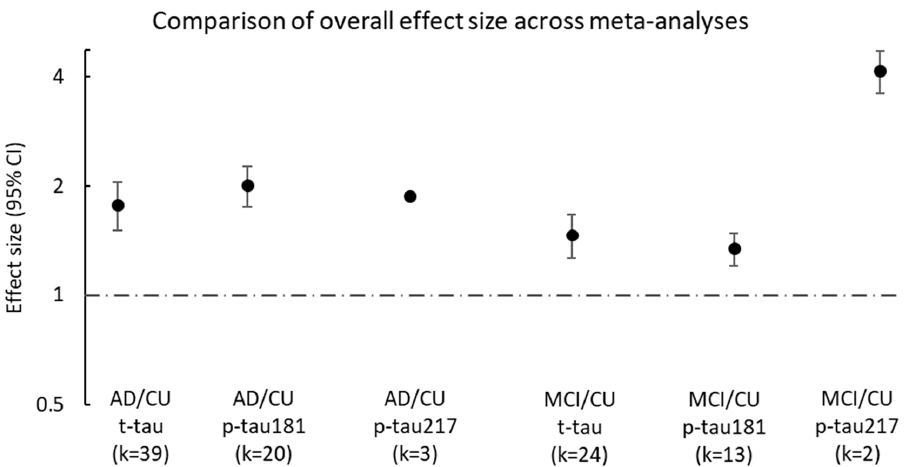
Figure 5. Overall effect size from each of the meta-analyses. The 6 meta-analyses are presented side by side and include plasma/serum p-tau181, p-tau217, and t-tau ratios of AD to CU and MCI to CU. Ratio (effect size) and 95% CI for each study are presented on the y-axis, where a ratio above 1 indicates greater biomarker concentrations in Alzheimer’s disease participants than in cognitively unimpaired participants. AD: Alzheimer’s disease; CU: cognitively unimpaired; MCI: mild cognitive impairment; k: number of studies pooled together in each meta-analysis; t-tau: total tau; p- tau181: phosphorylated tau at threonine 181; p-tau217: phosphorylated tau at threonine 217.